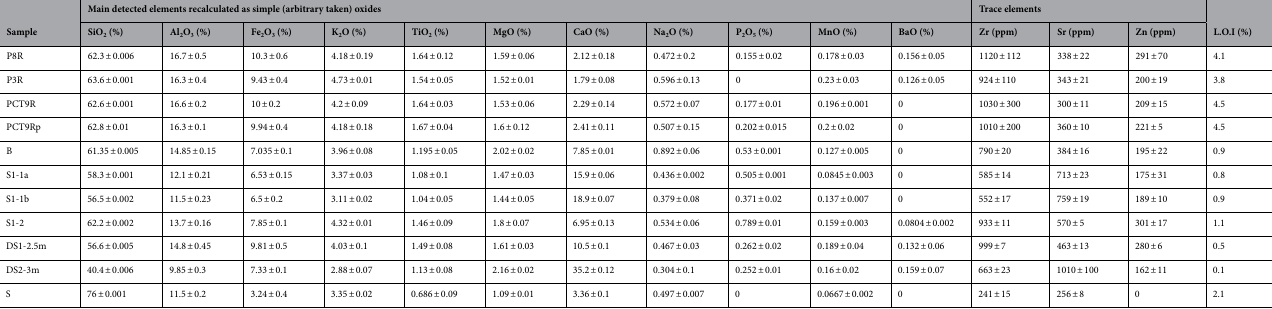
Table 2. X-ray fluorescence average compositions (wt.%) in the oxide representation (the total is 100 wt.%) considering the main detected elements in the burnt (B) and mud (S1-1a, S1-1b, S1–2) bricks, raw sand (S), raw soils (low- and high- depth) from Romula. Standard deviations from the average values for three measurements on each sample are given. L.O.I values were estimated after heating the samples at 100